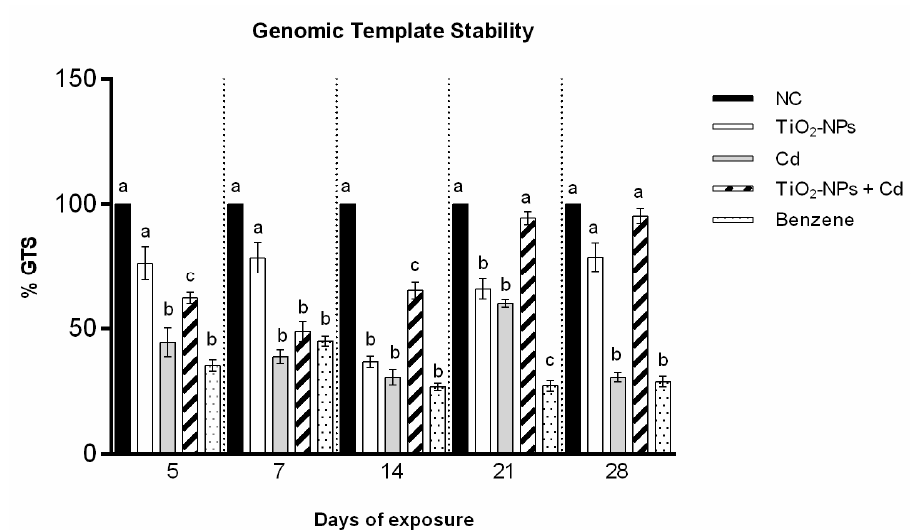
Figure 6. Changes in percentage of genome template stability (ordinate) in zebrafish blood cells DNA (three DNA pools for each treatment) after different exposure times (abscissa) to TiO 2 -NPs, Cd and to TiO 2 -NPs + Cd co-exposure. The black bars are negative controls (NC); the white bars are 10 µ g/L TiO 2 -NPs; the grey bars are 1 mg/L Cd; the striped bars are 10 µ g/L TiO 2 -NPs + 1 mg/L Cd co-treated zebrafish. The dotted bars are positive controls (benzene 10 µ L/mL). Different letters correspond to diverse statistical significances (ANOVA)* p ≤ 0.05. Table 1. Molecular sizes (bp) of appeared and disappeared bands by RAPD-PCR technique in zebrafish DNA exposed to Cd (1 mg/L), to TiO 2 -NPs (10 µ g/L), to Cd (1 mg/L) + TiO 2 -NPs (10 µ g/L) and to benzene (10 µ L/mL) for different exposure times. a Control bands are at: 200, 220, 250, 290, 320, 400, 450, 500, 550, 600, 800 bp.